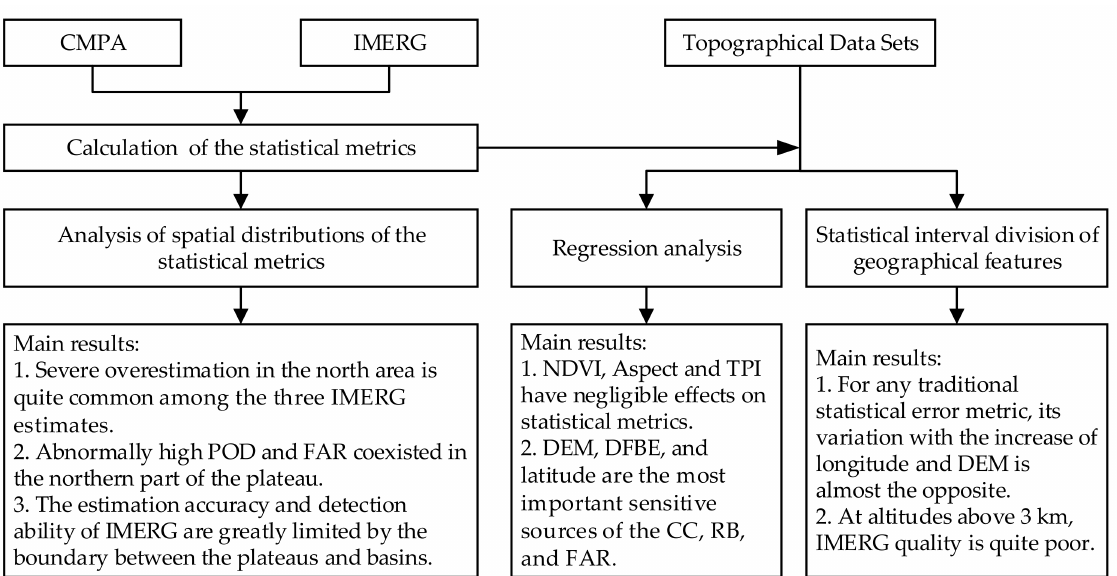
Figure 5. The flowchart of the analysis of the traditional statistical error metrics.